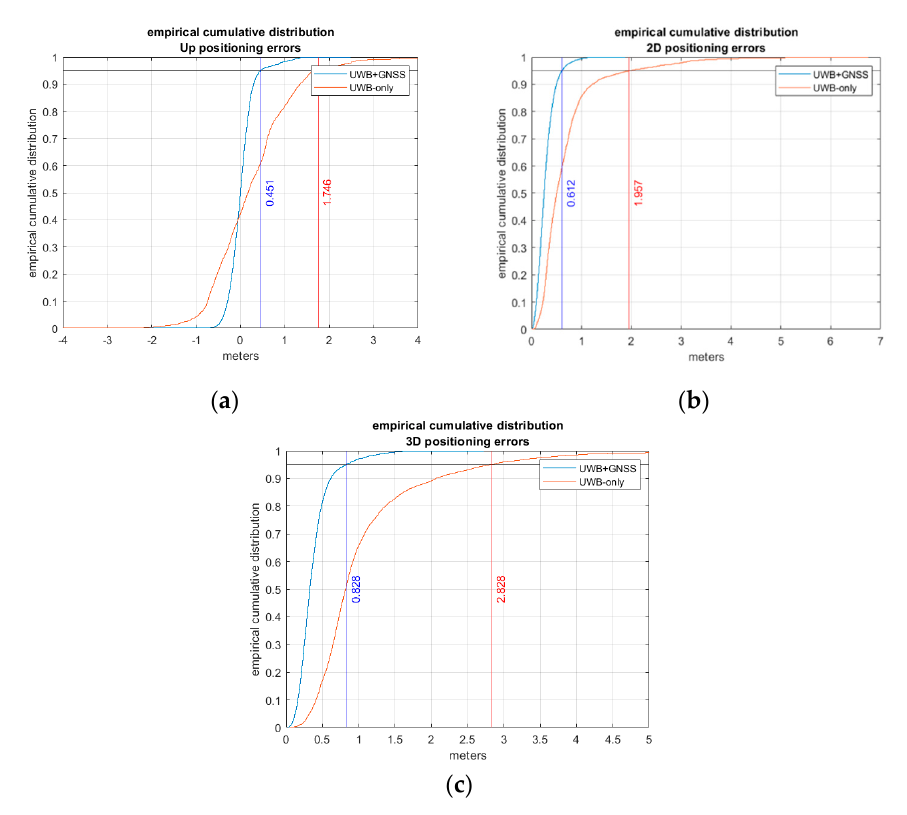
Table 8. Overall vertical positioning error. UWB-Only